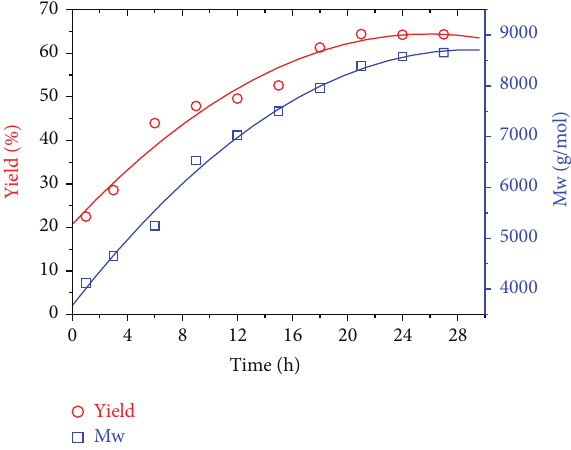
Figure 6: Effect of catalyst amount on the molecular weight and yield for the polymerization of CHO in CH 2 Cl 2 at 40 ∘ C over H 3 PW 12 O 40 .